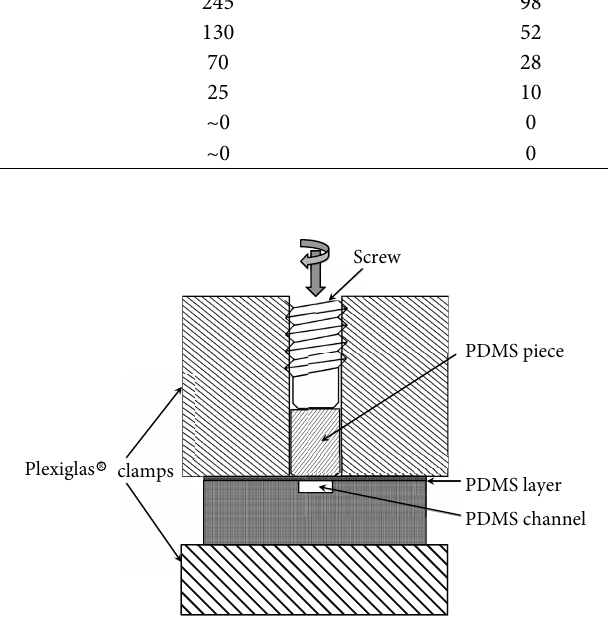
Figure 7: Actuator structure of the